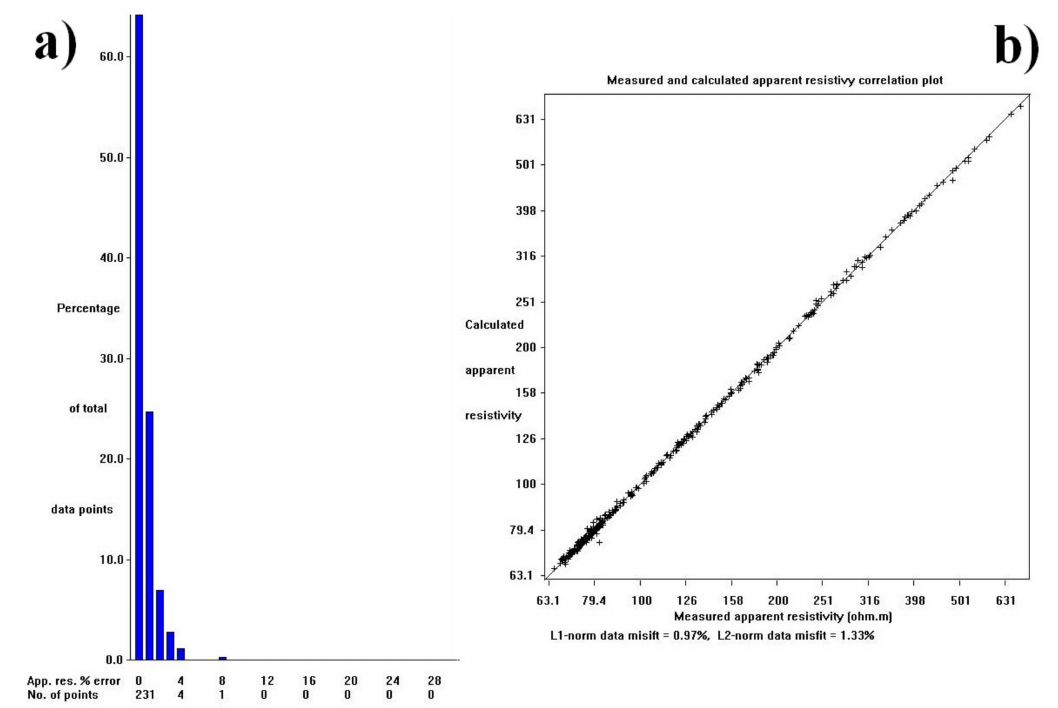
Figure 15. ( a ) Error histogram for Wenner array; and ( b ) the correlation plot of the relative resistivity measured and obtained on the basis of inversion carried out with Res2Dinv program.